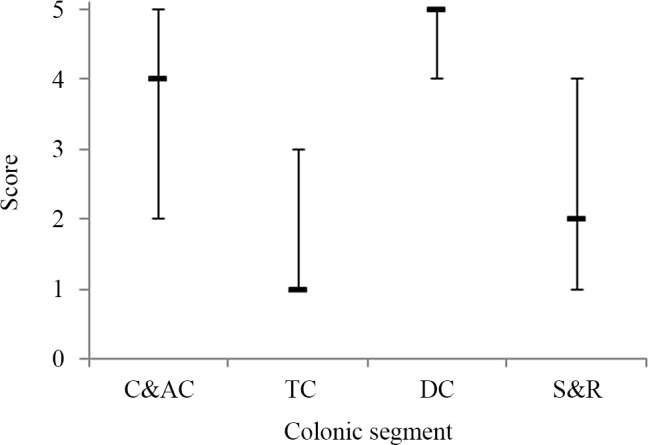
The 25th centile, median, 75th centile of the scores from 5 observers for the presence of 18FDG in the 4 sections of the colon